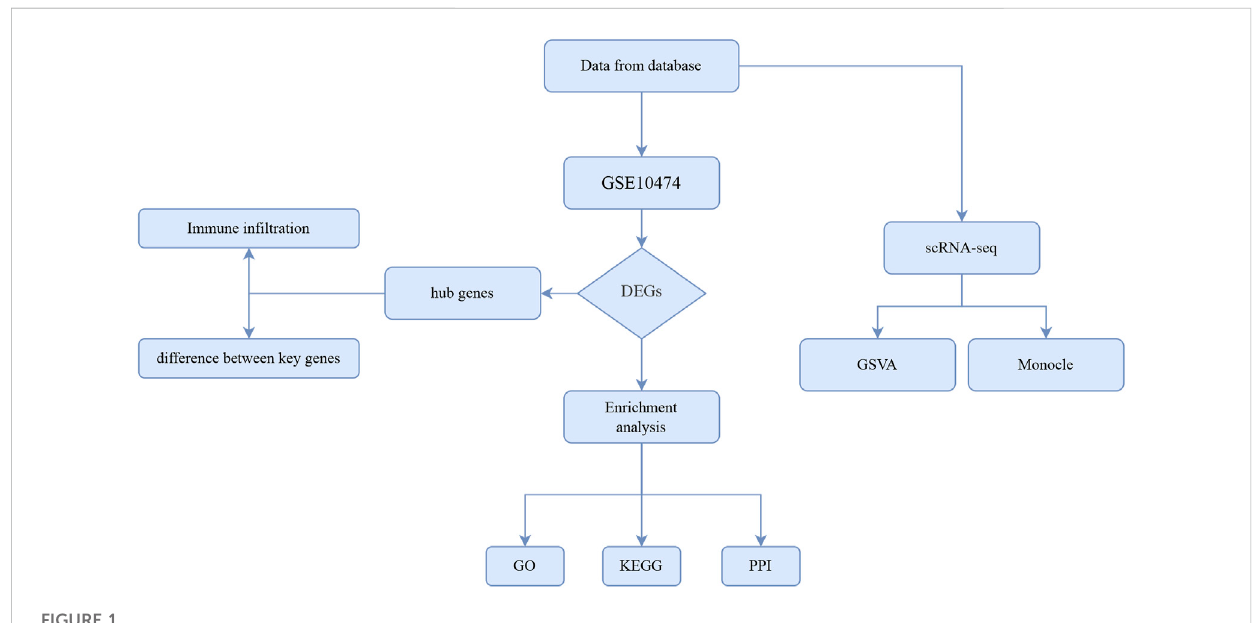
FIGURE 1 The overall technical route of this